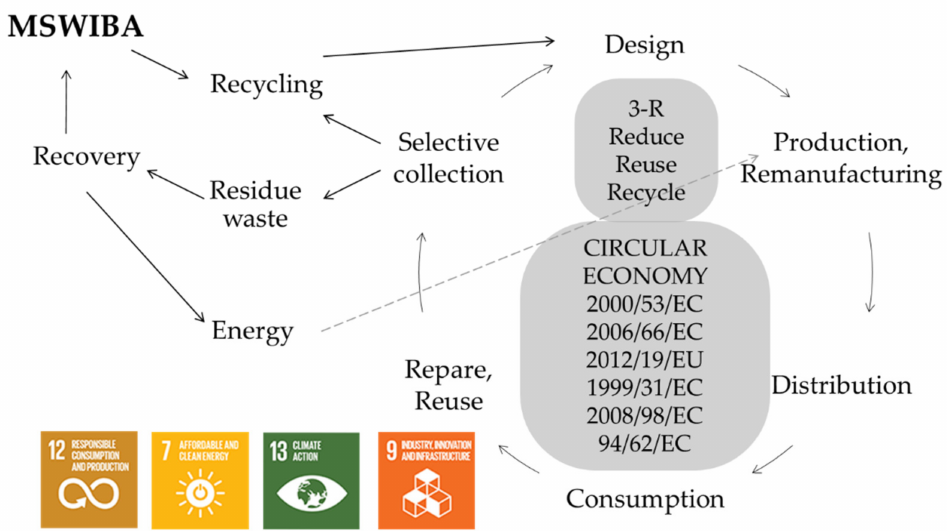
Figure 2. MSWIBA ideal circular economy and attributed SDGs [11,12].